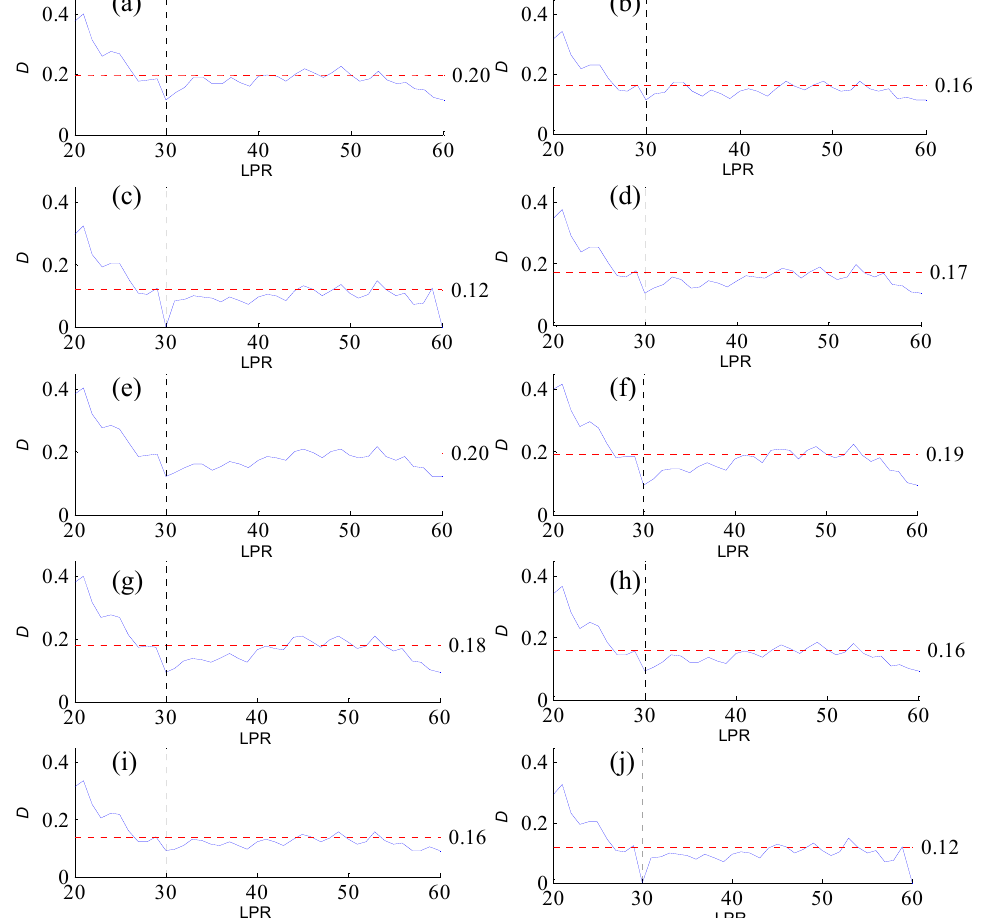
Figure 1. Variation of flow regime alteration degree (D) measured by the range of variation approach (RVA) with changes in length of the pre-impact flow time series (LPR) under a periodicity of 30 years. ( a – j ) correspond to a post-impact flow time series of length = 21, 26, 30, 34, 39, 43, 47, 51, 56, and 60 years, respectively. The abscissa value for the vertical dotted line is 30. The ordinate value for the horizontal dotted line is the mean degree of flow regime alteration in each subfigure.